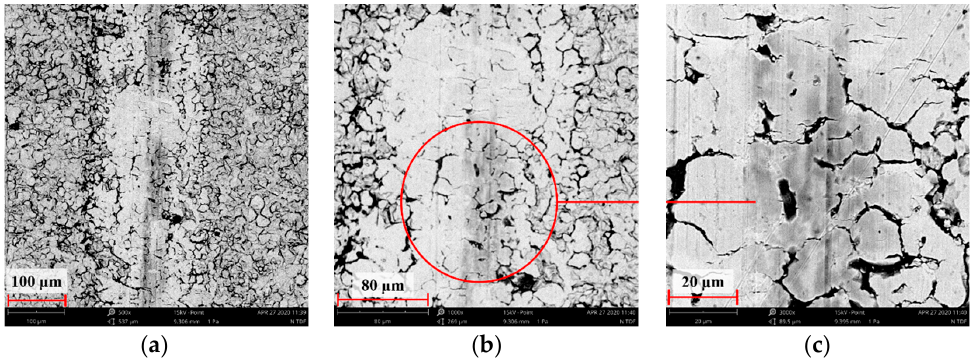
Figure 21. SEM image of the nitrogen ion-implanted steel 316L wear track after dry sliding: ( a ) × 500, ( b ) × 1000, ( c ) × 3000.